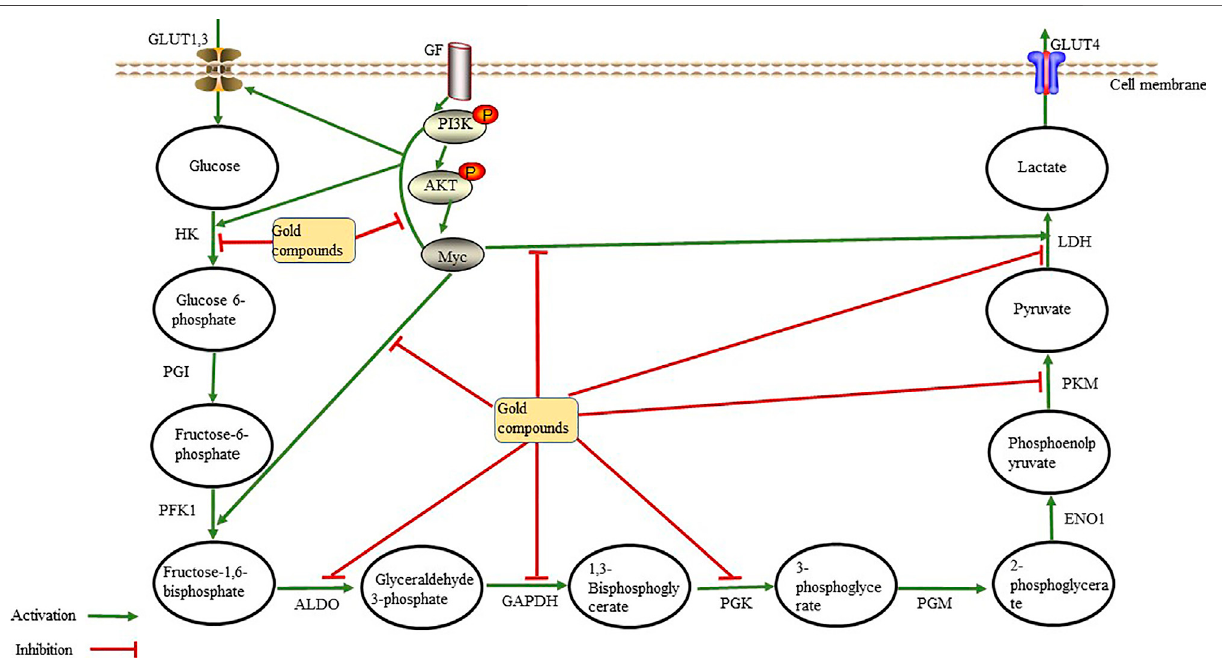
Frontiers in Chemistry |